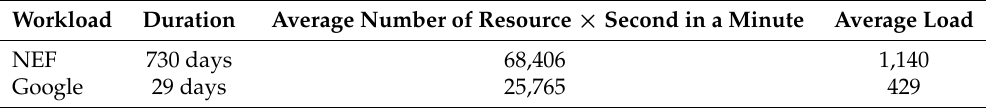
Table 2. Characteristics of the workloads used in the